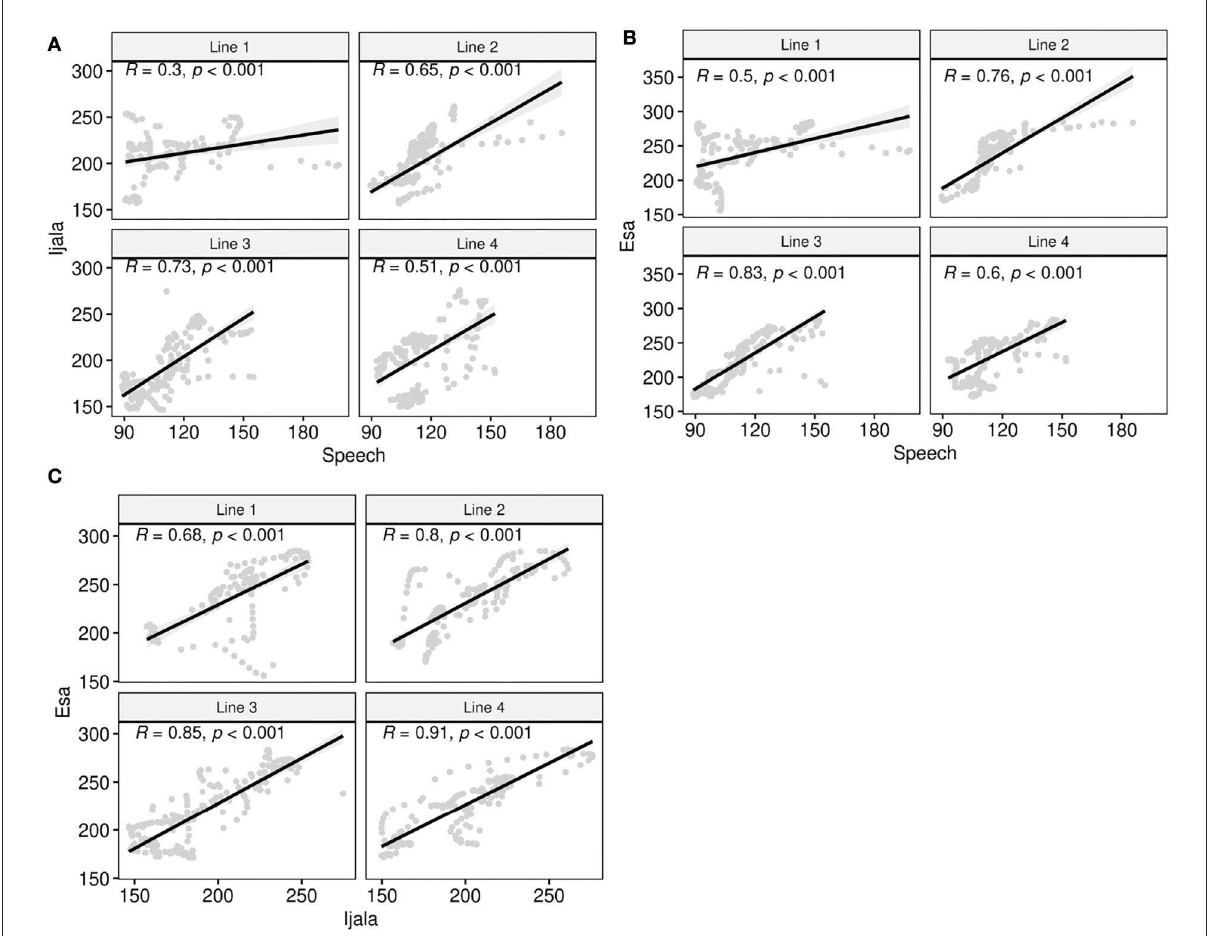
FIGURE5 Correlation between the pitch trajectories of each line in speech and poetic modes: (A) Ìjálá vs. speech; (B) È.sa vs. speech; (C) È.sa vs. Ìjálá.